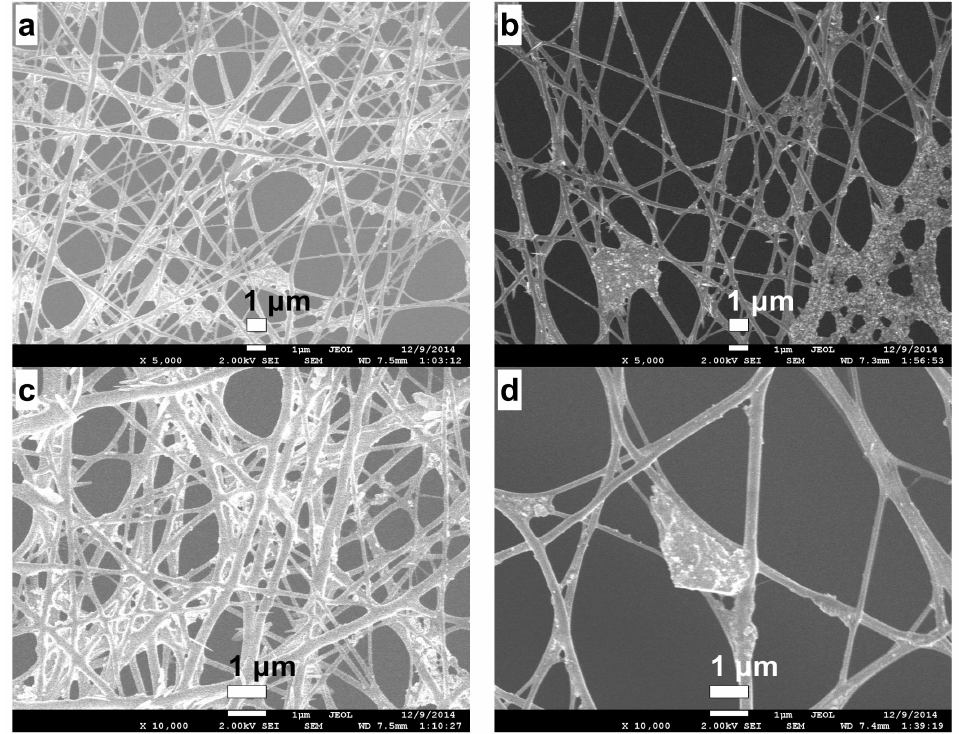
Figure 7. SEM micrographs of CS/PVA electrospun nanofibers deposited on RVC for 90 min before ( a , c ) and after ( b , d ) ethanolic NaOH solution treatment.